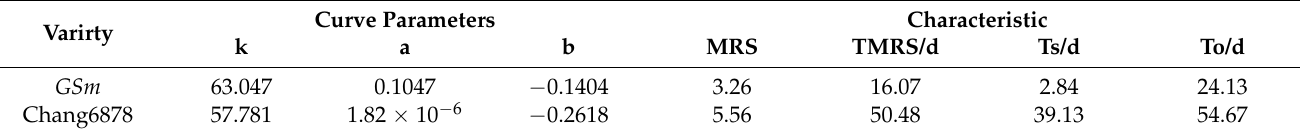
Figure 2. Photosynthetic fluorescence indices of flag leaf samples from the wheat premature senes- cence mutant ( GSm ) and its wild-type (WT). ( A ) Chlorophyll content; ( B ) Net photosynthetic rate, Pn; ( C ) Transpiration rate, Tr; ( D ) efficiency of primary conversion of light energy of photosystem II, Fv/Fm; ( E ) Non-photochemical quenching coefficient, NPQ; ( F ) Photosynthetic electron transport rate, ETR. Vertical bars represent standard errors with three independent biological replicates. Table 2. aging characteristic parameters of wild type and mutant.